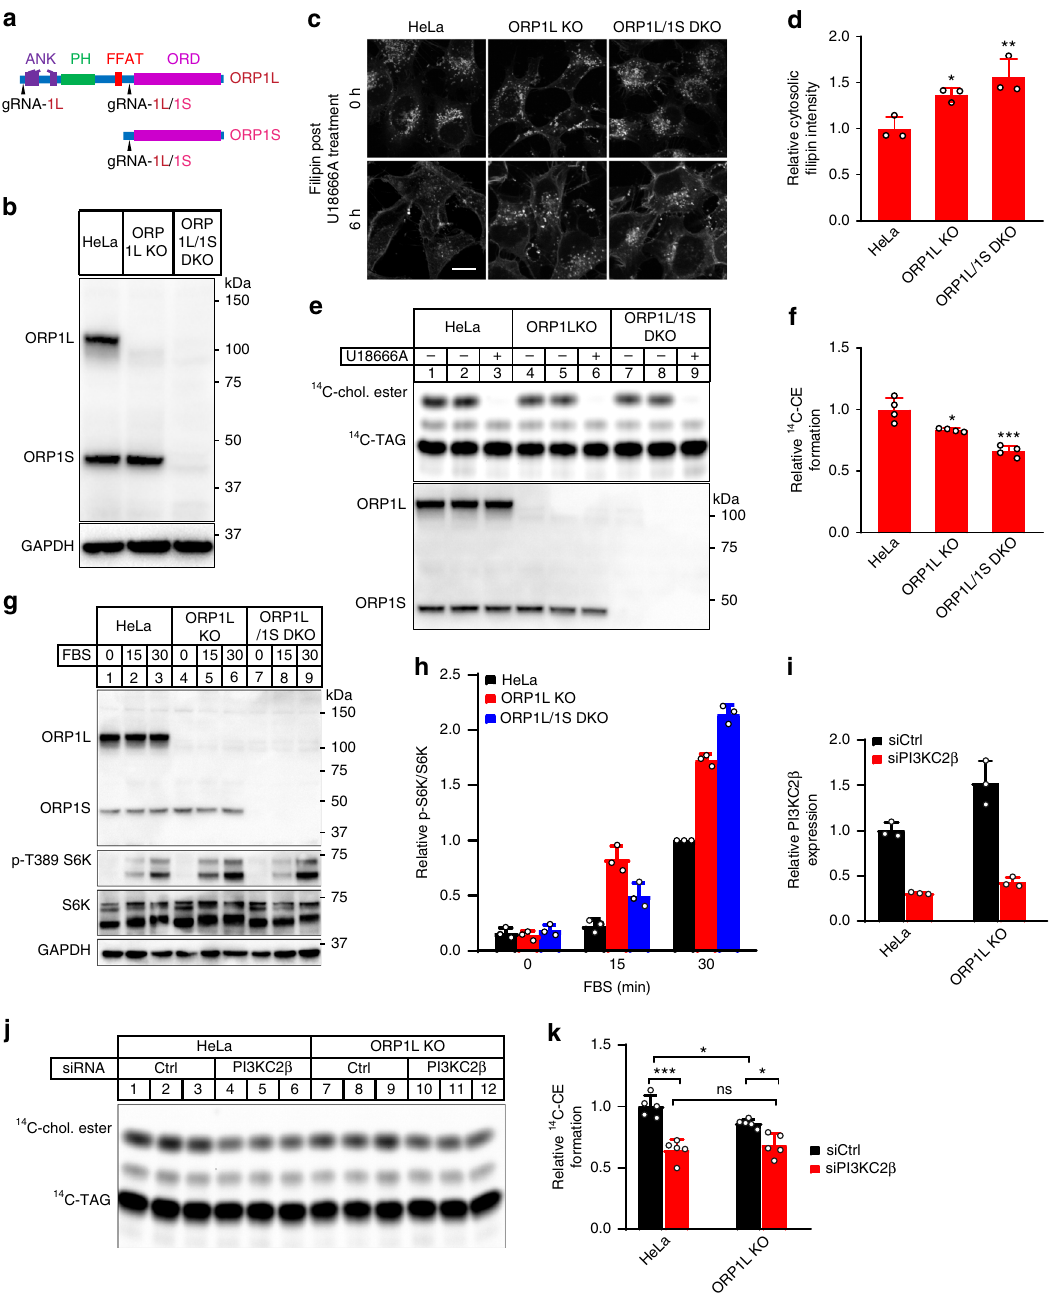
Fig. 2 ORP1L is involved in endosomal cholesterol transport and signaling. a Guide RNA targeting sites for ORP1L and ORP1S. b Western blotting analysis of HeLa, ORP1L KO, and ORP1L/ORP1S DKO cells. c U18666A-mediated LEL cholesterol release assay in HeLa, ORP1L KO, and ORP1L/1S DKO cells (scale bar = 10 μ m). d Quantitation of cytosolic fi lipin intensities of cells (6 h) in c . e Cholesterol esteri fi cation assay in HeLa, ORP1L KO, and ORP1L/1S DKO cells. TAG, triacylglycerol. f Quantitation of cholesteryl [ 14 C]-esters formation in e by densitometry. g Western blotting analysis of HeLa, ORP1L KO, and ORP1L/ORP1S DKO cells starved in EBSS and then chased with FBS. h Densitometry of p-S6K/S6K in g . All values are means ± s.d. (error bar) (* p < 0.05; ** p < 0.01; *** p < 0.001; ns, not signi fi cant; n = 3 – 10) Statistical analyses use one-way ANOVA. i qRT-PCR analysis of PI3KC2 β knockdown in ORP1L KO and HeLa control cells. j Cholesterol esteri fi cation assay in ORP1L KO and HeLa control cells with or without siPI3KC2 β knockdown. k Quantitation of cholesteryl [ 14 C]-esters formation in j by densitometry